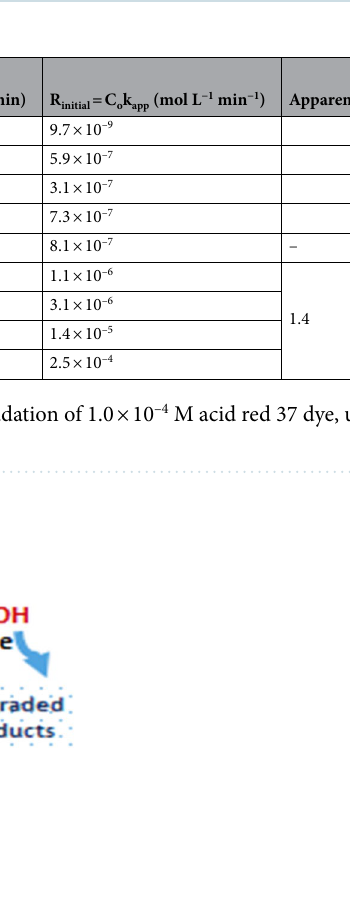
Figure 11. Proposed mechanism of Ag NPs-role as a photocatalyst, upon UV-irradiation.